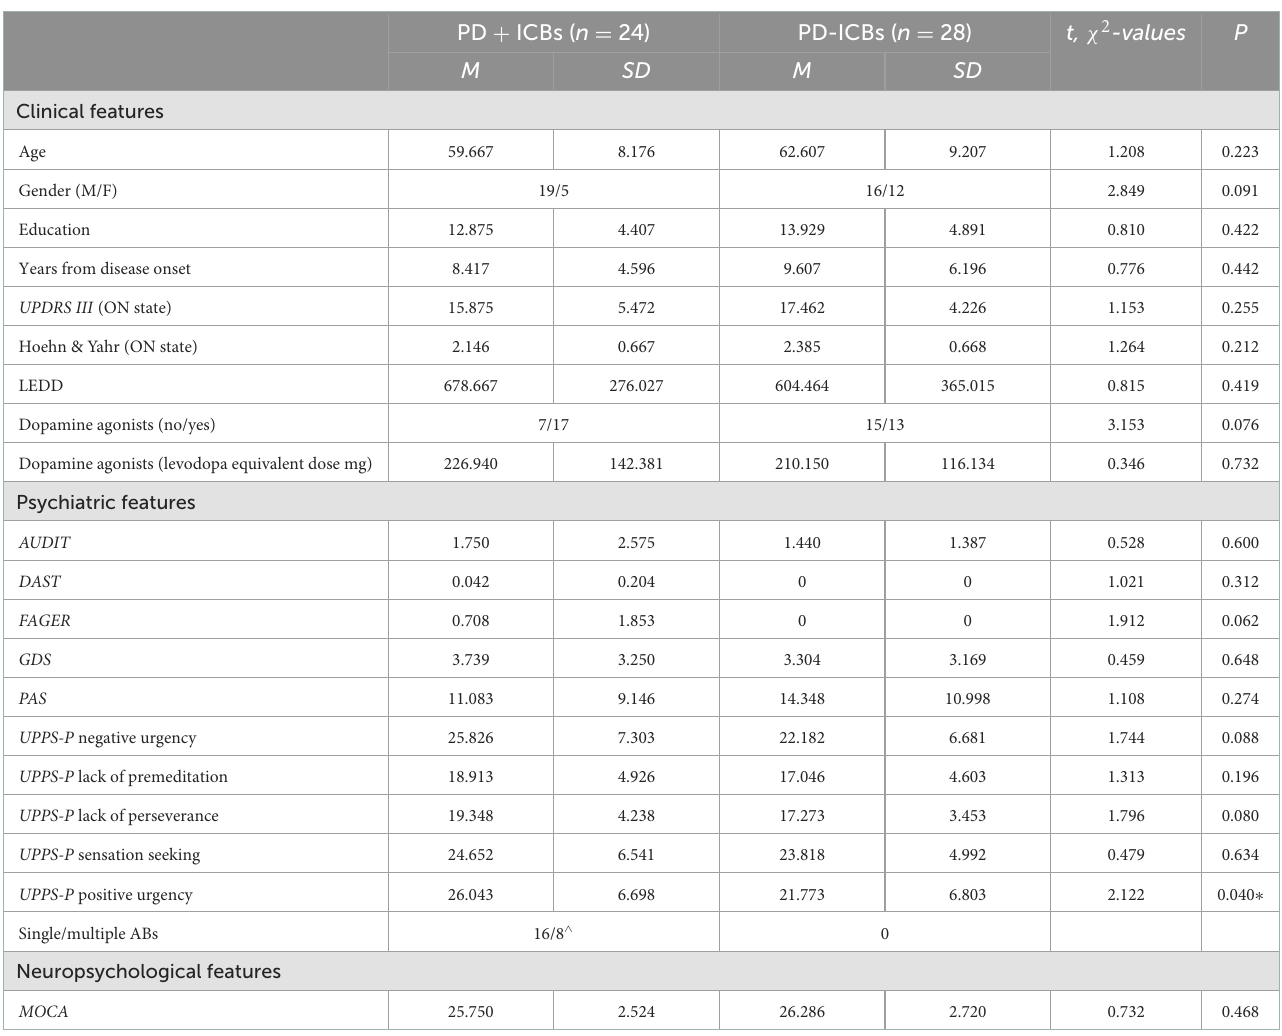
TABLE 1 Demographic, neurological, and clinical characteristics of